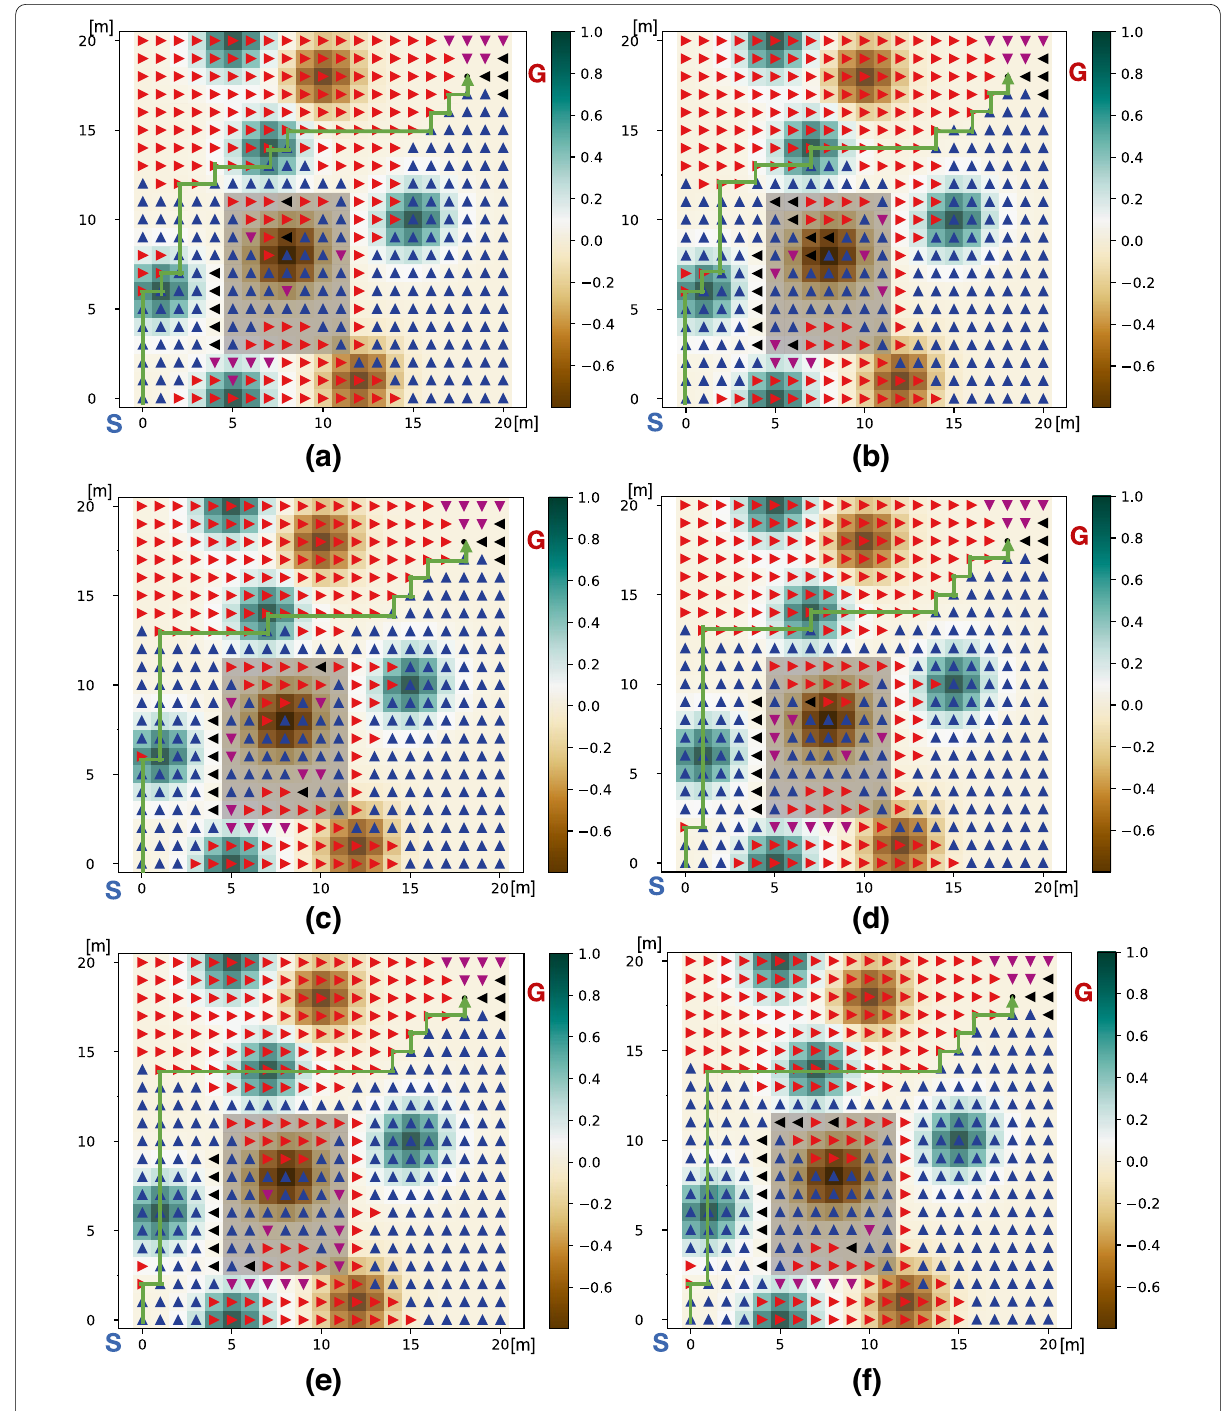
Fig. 6 The path planning results on heterogeneous terrain (1); a : ( w 1 , w 2 ) = ( 0,1 ) , b : ( w 1 , w 2 ) = ( 0.1,0.9 ) , c : ( w 1 , w 2 ) = ( 0.2,0.8 ) , d : ( w 1 , w 2 ) = ( 0.3,0.7 ) , e : ( w 1 , w 2 ) = ( 0.4,0.6 ) , f : ( w 1 , w 2 ) = ( 0.5,0.5